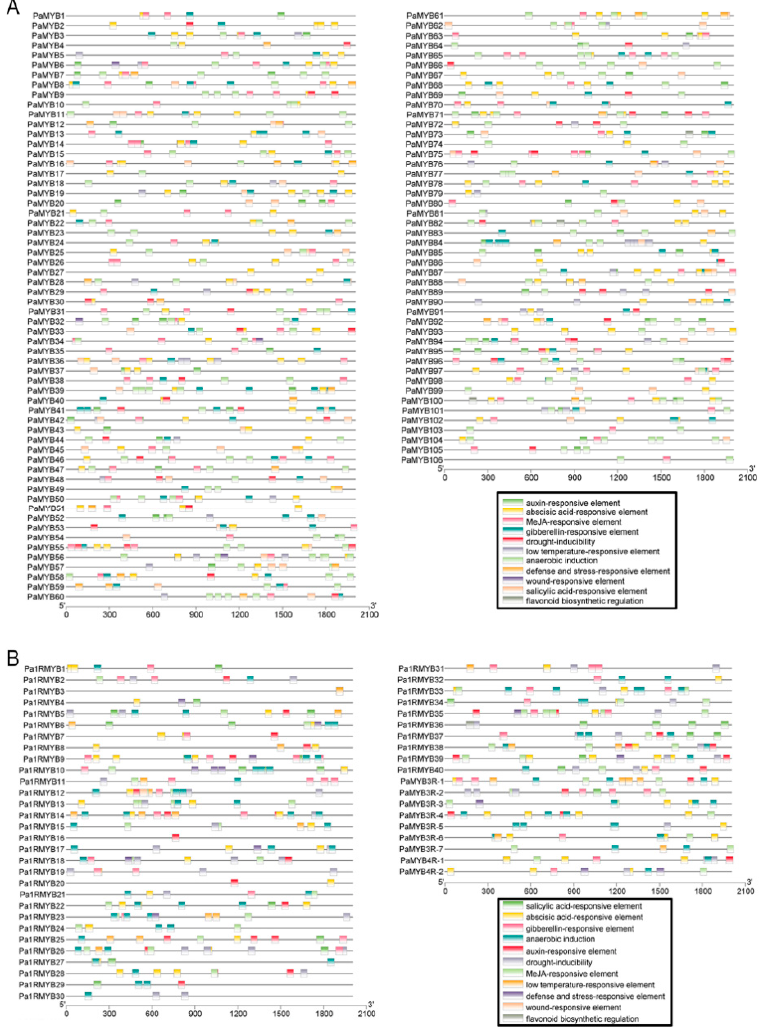
Figure 4. Regulatory elements in the promoter region of MYB genes in Petunia : ( A ) Regulatory elements in R2R3-MYB genes promoter. Different colors of box indicate different cis-elements; ( B ) Regulatory elements in 3R, 4R and 1R-MYB genes promoter.